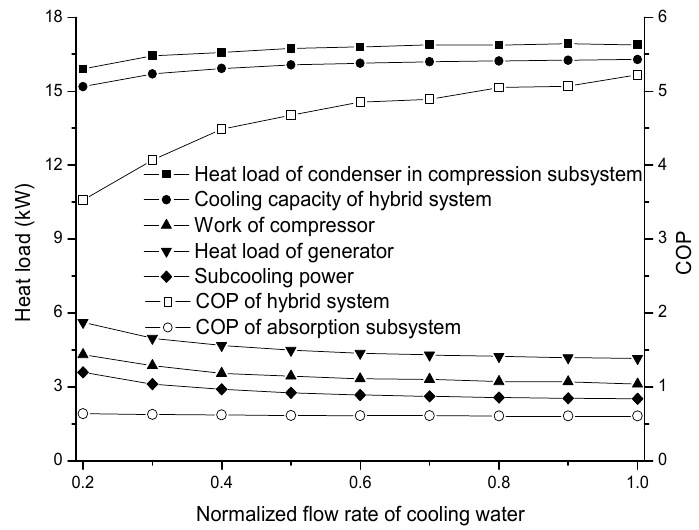
Figure 10. Performance with the flow rate of cooling water in the compression subsystem.